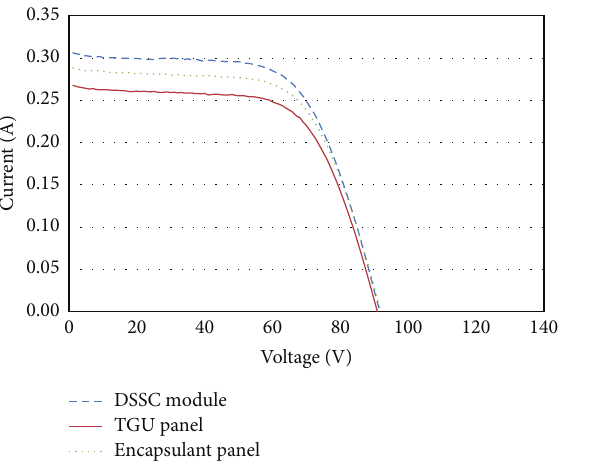
Figure 8: 𝐼 - 𝑉 curves of the DSSC module and panels.